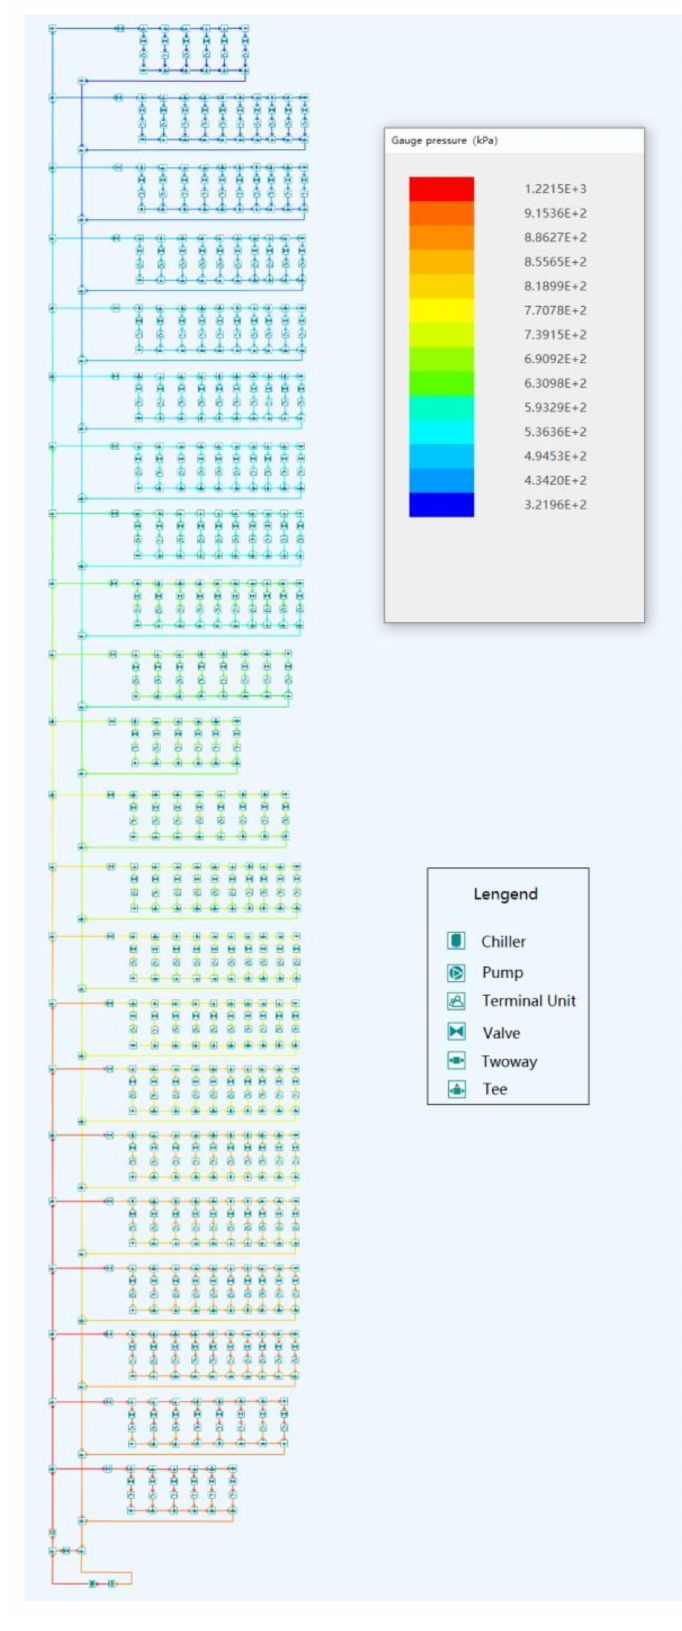
Figure 11. Water pressure